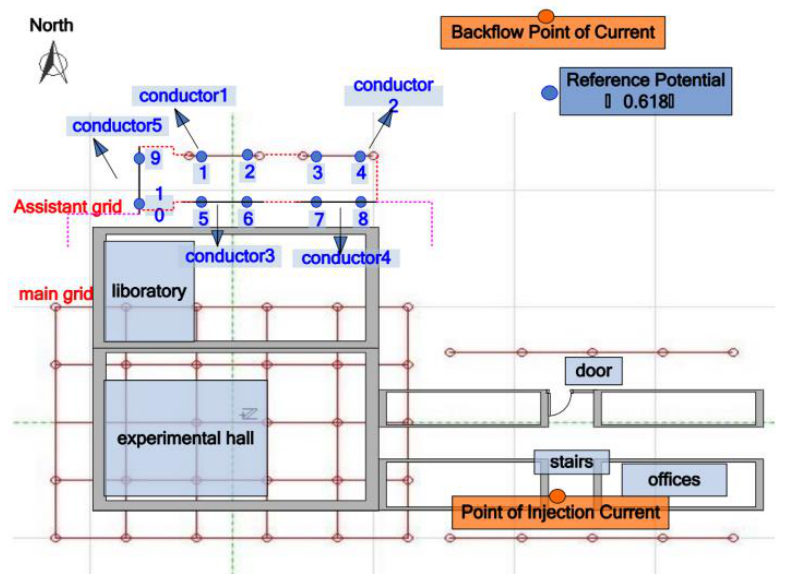
Figure 9. A ten observation points model of an actual grounding grid [99].